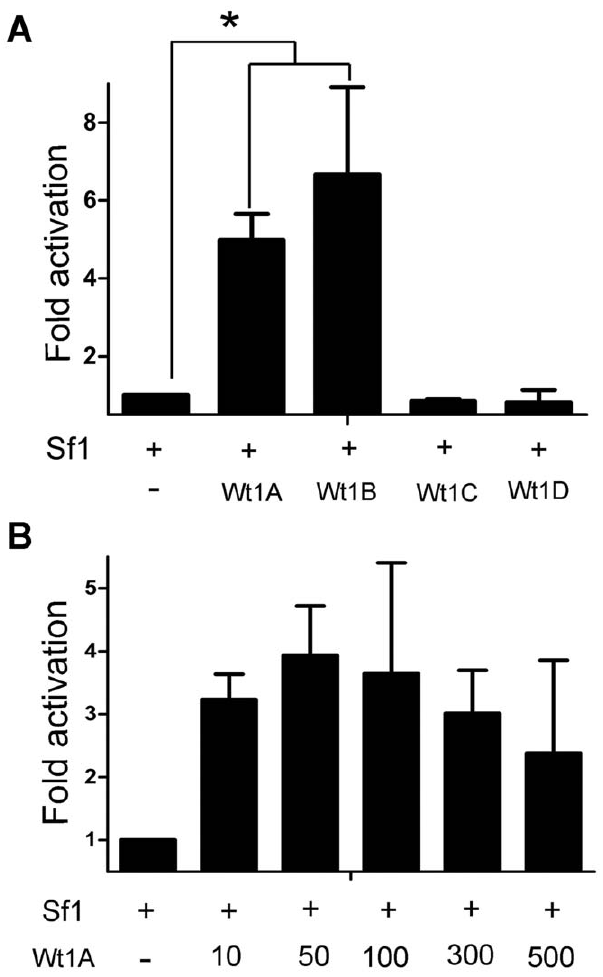
Figure 5. The inhibin- a promoter is synergistically activated by Sf1 and the Wt1 A and B, but not C and D isosforms, and Wt1 synergizes with Sf1 in a dose-independent manner. A. Luciferase activity indicated that the inhibin- a promoter is significantly transacti- vated by Wt1 A and B and Sf1 co-transfection, but transfection of Sf1 and Wt1 C and D isoforms did not change the luciferase activity compared to the control. B. No difference in luciferase activity was noted when Sf1 was co-transfected with different doses of Wt1 A (10, 50, 100, 300, 500 ng).